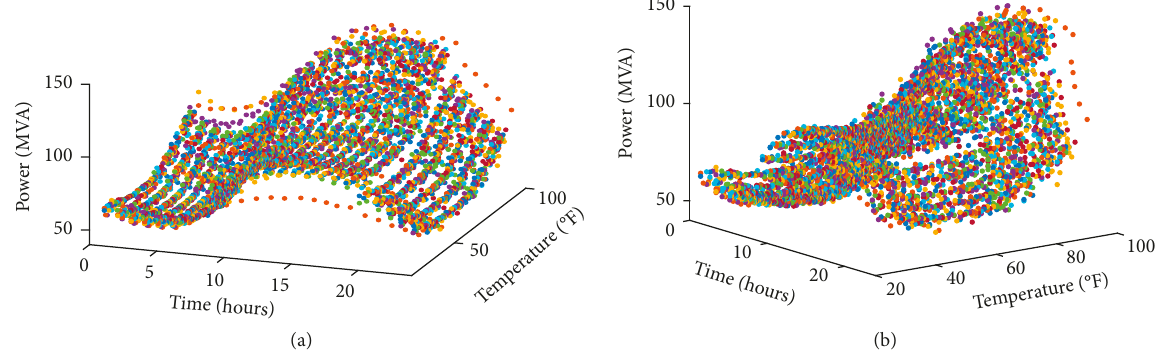
Figure 5: Relation between power consumption, temperature, and time of the day for all weekdays of 2010: (a) front view; (b) side